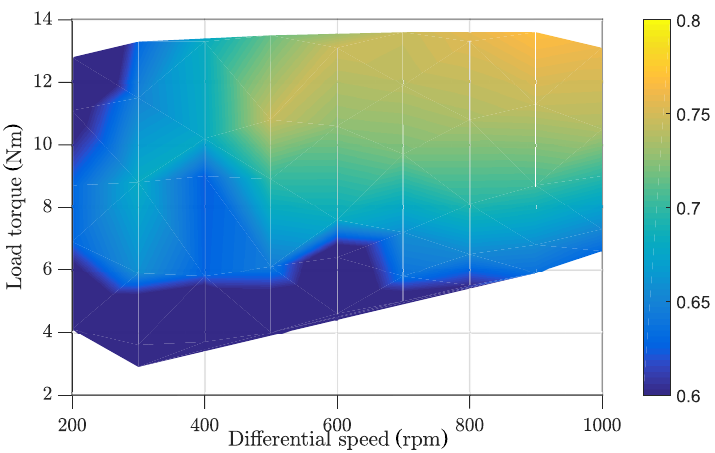
Figure 13. Prototype generator efficiency diagram from measurements at the dynamometer stand.